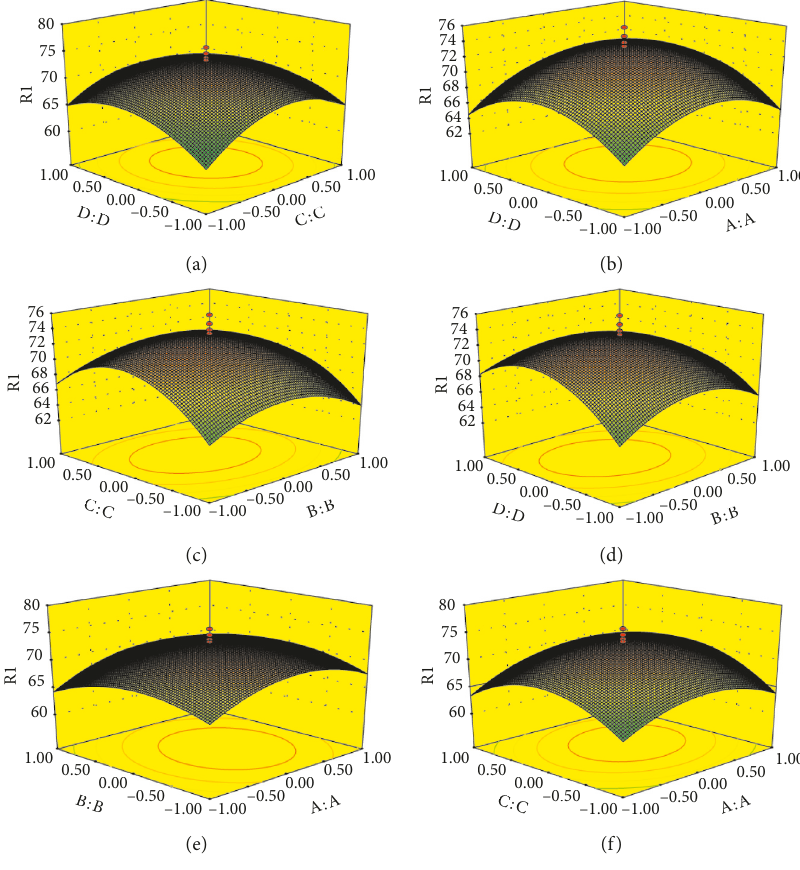
Figure 11: The response surface of product IV . Table 3: Impact of the phase transfer catalyst on yield. Phase transfer